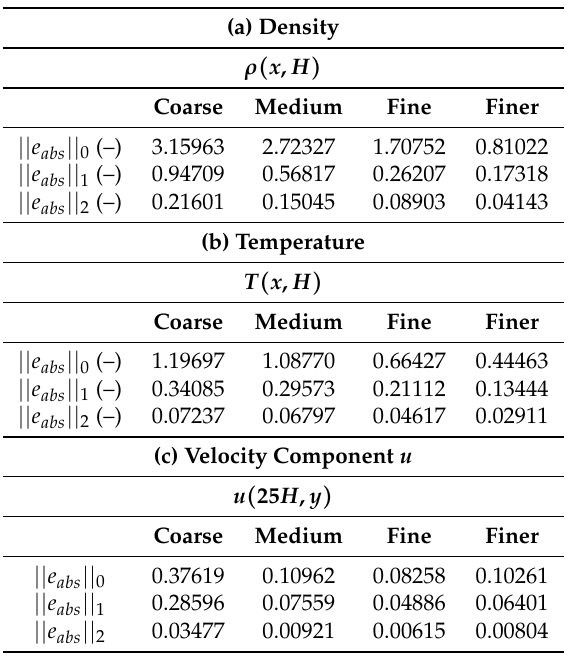
Table 4. L 0 , L 1 and L 2 norms of the absolute error between the results achieved with DG–FEM and reference data in [21]. Results presented for density ( a ), temperature ( b ) in the centerline of the microchannel, and stream wise velocity ( c ) in the cross section x = 25 H . Results obtained at the final time T f = 80 µ s with Kn =